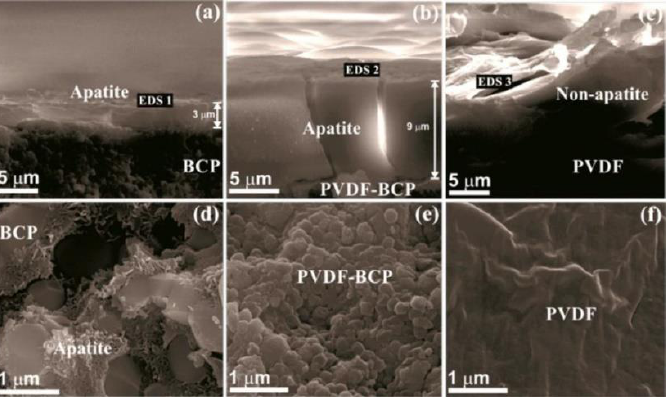
Figure 7. Cross-sectional and top view SEM images of ( a , d ) BCP, ( b , e ) PVDF-BCP, and ( c , f ) PVDF. Reproduced with permission from [105]. Copyright SciELO, 2018.